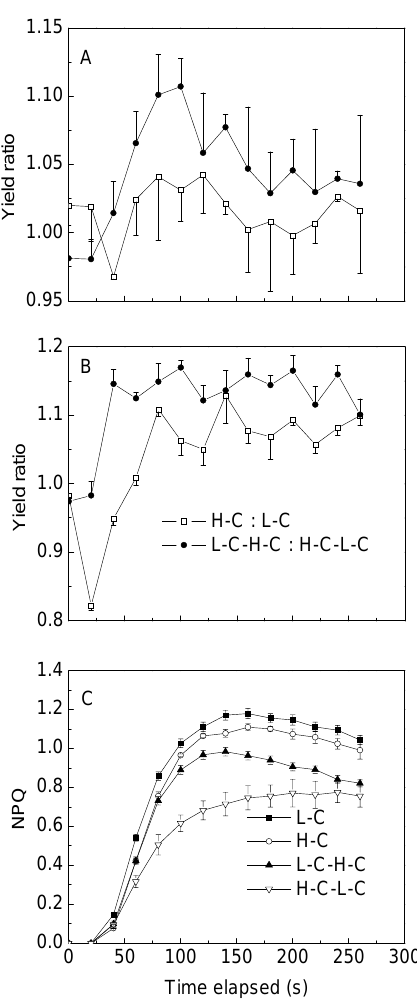
Fig. 5. The effective quantum yield ratios of high (H-C) to low CO 2 grown cells (L-C), that of L-C cells measured in H-C medium (L-C-H-C) to H-C cells measured in L-C medium (H-C-L-C) un- der (A) 120 and (B) 840µmol m − 2 s − 1 , respectively; and (C) non- photochemical quenching (NPQ) under 840µmol m − 2 s − 1 for L-C, H-C, L-C-H-C and H-C-L-C. Vertical bars represent SD, n